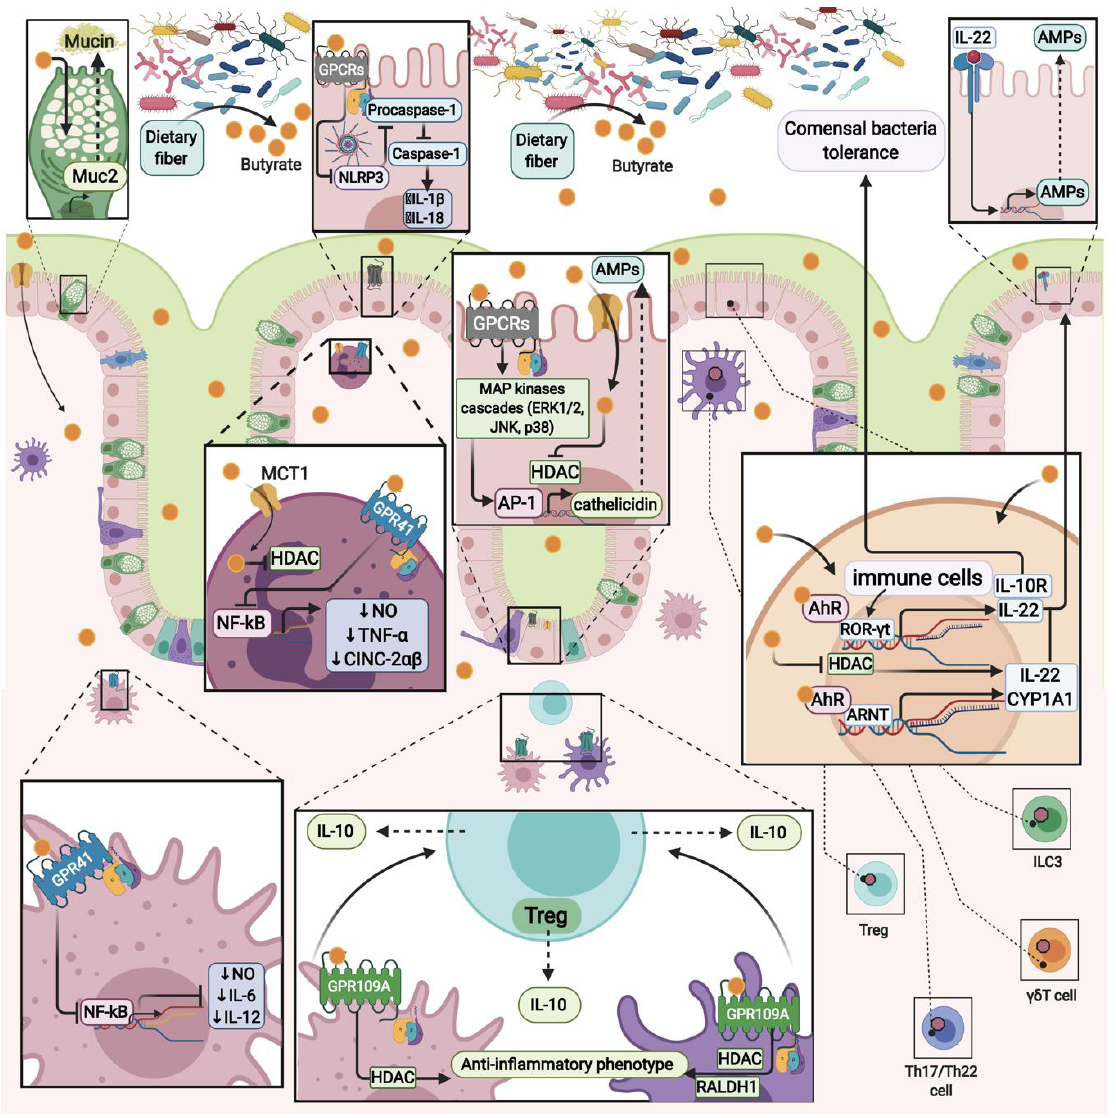
Figure 2. Different anti-inflammatory mechanisms of butyrate: histone deacetylase (HDAC) inhibition, aryl hydrocarbon receptor (AhR) and G-protein coupled receptors (GPCRs) activation.